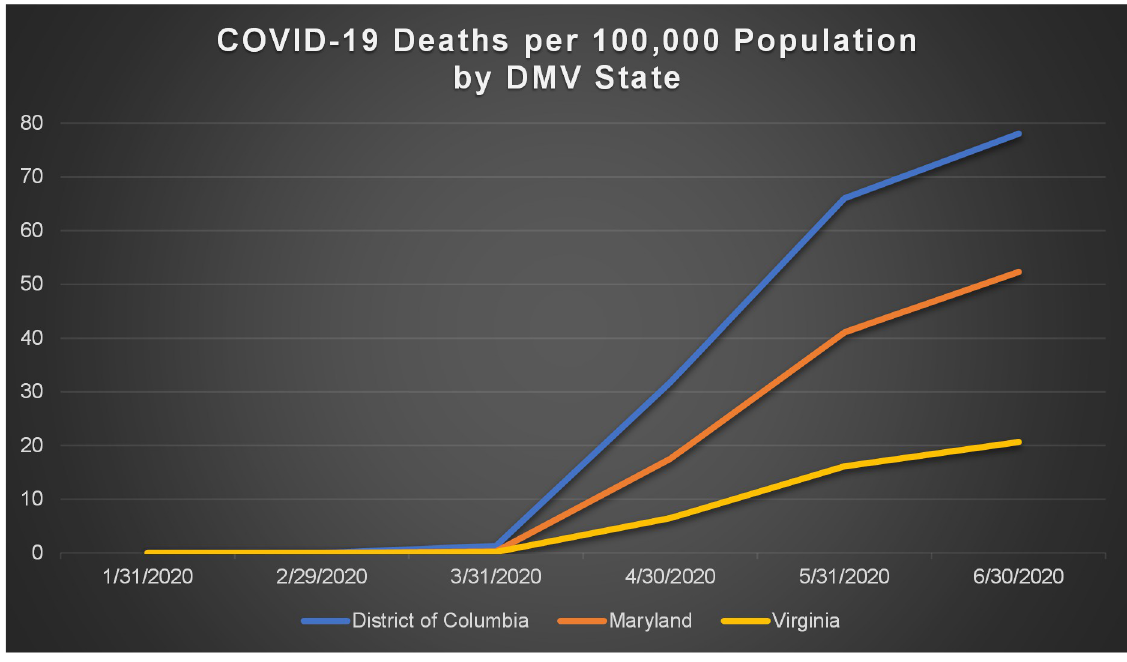
Fig 2. COVID-19 deaths per 100,000 population by DMV state.